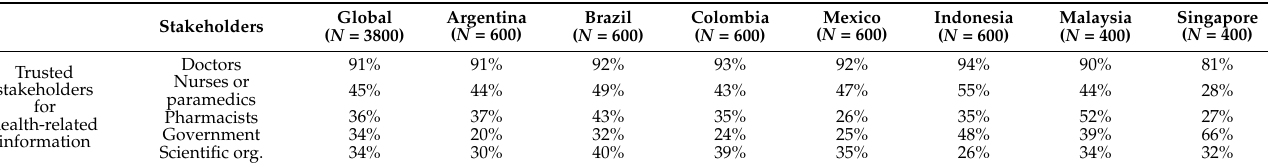
Table 6. Top 5 trusted stakeholders for health-related